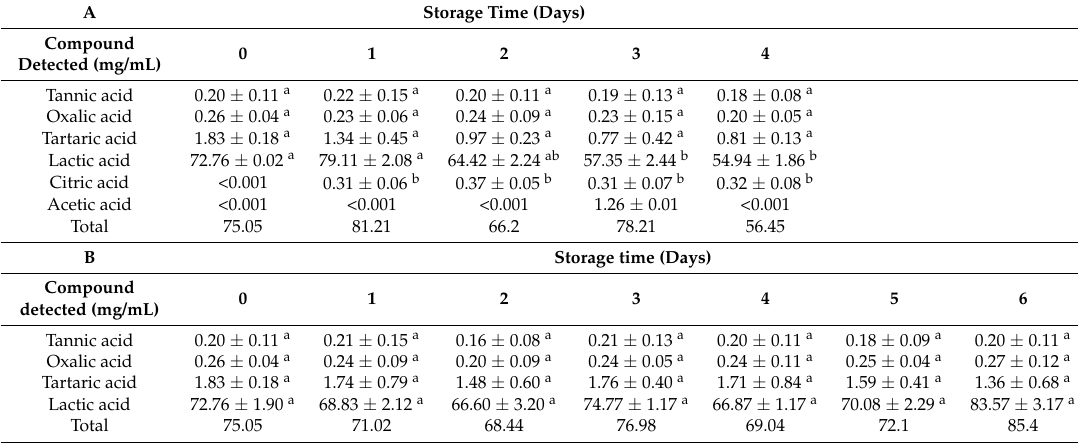
Table 2. Organic acids detected during the storage of tchapalo at ( A ) ambient temperature (28 to 30 ◦ C) for four days and ( B ) 4 ◦ C for six days.